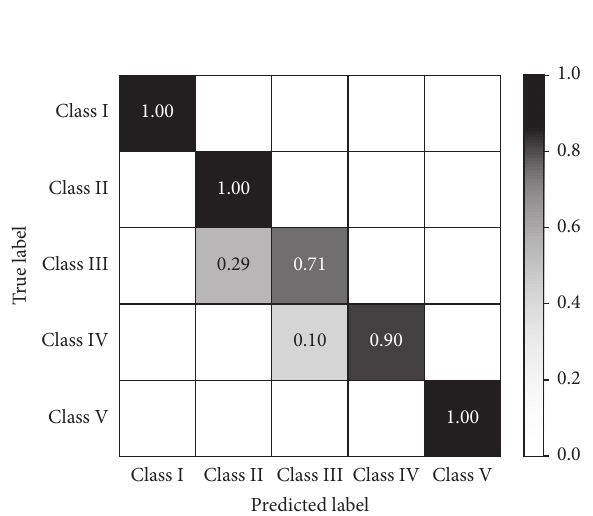
Figure 3: Confusion matrix of the classification